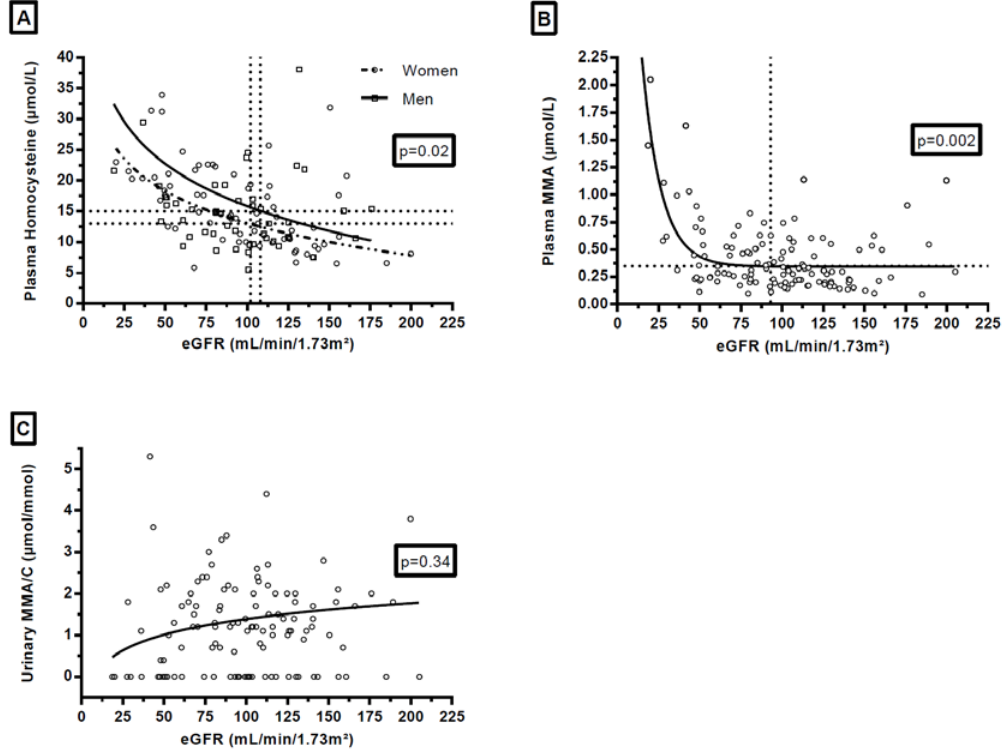
Figure 2. Influence of renal function on plasma homocysteine ( A ) in women and in men, plasma methylmalonic acid ( B ) and urinary methylmalonic acid to creatinine ratio ( C ). Footnotes: p -values on the graphs referred to the results of the F test on slopes. For enhanced clarity, y-axis was releveled, and 3 plasma HCyst values (56.3, 93.6, and 129 µmol/L) and 1 uMMA/C value (27.1 µmol/mmol) were outside the graphs. The values which correspond to the horizontal dotted lines of the graphs are: 13 µmol/L for graph A for women, 15 µmol/L for graph A for men, and 0.35 mmol/L for the graph B. The values which correspond to the vertical dotted lines of the graphs are: 102 mL/min/1.73 m² for graph A, 108 mL/min/1.73 m² for graph A, and 93 mL/min/1.73 m² for the graph B.